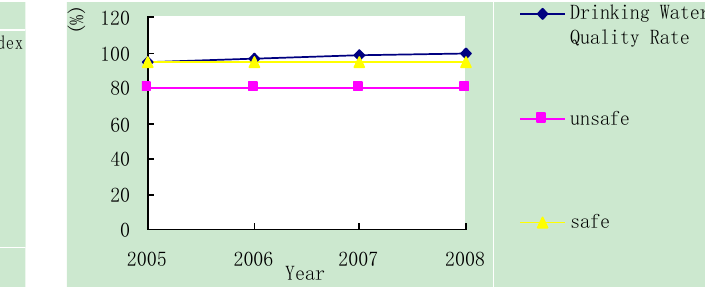
( d ) The key indicators of the impact subsystem